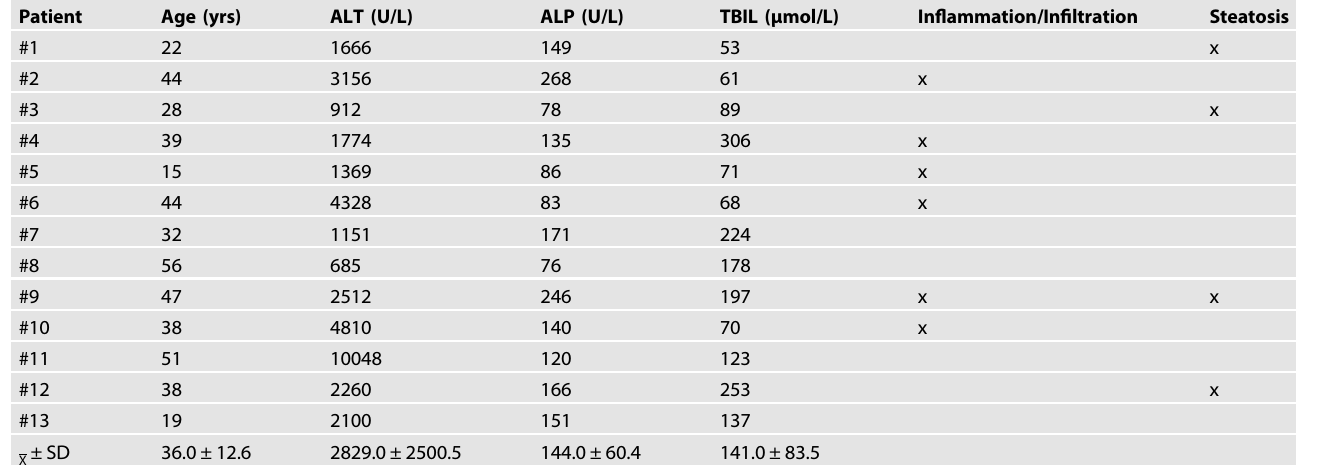
Table 1. Clinicopathological characteristics of the patients used in this